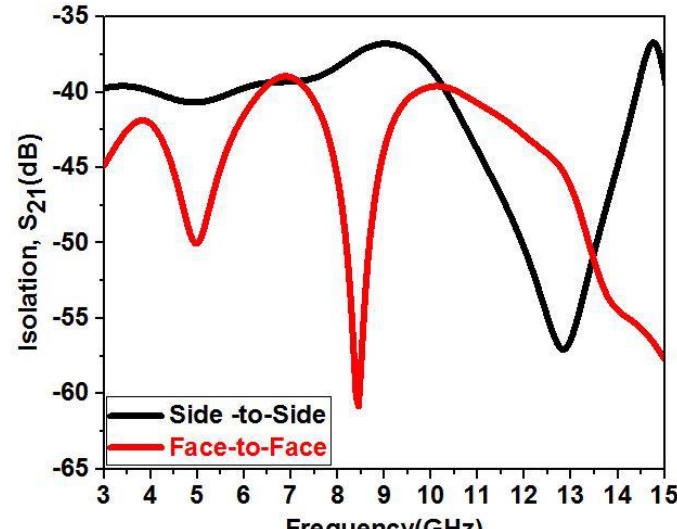
Figure 29. Group delay.